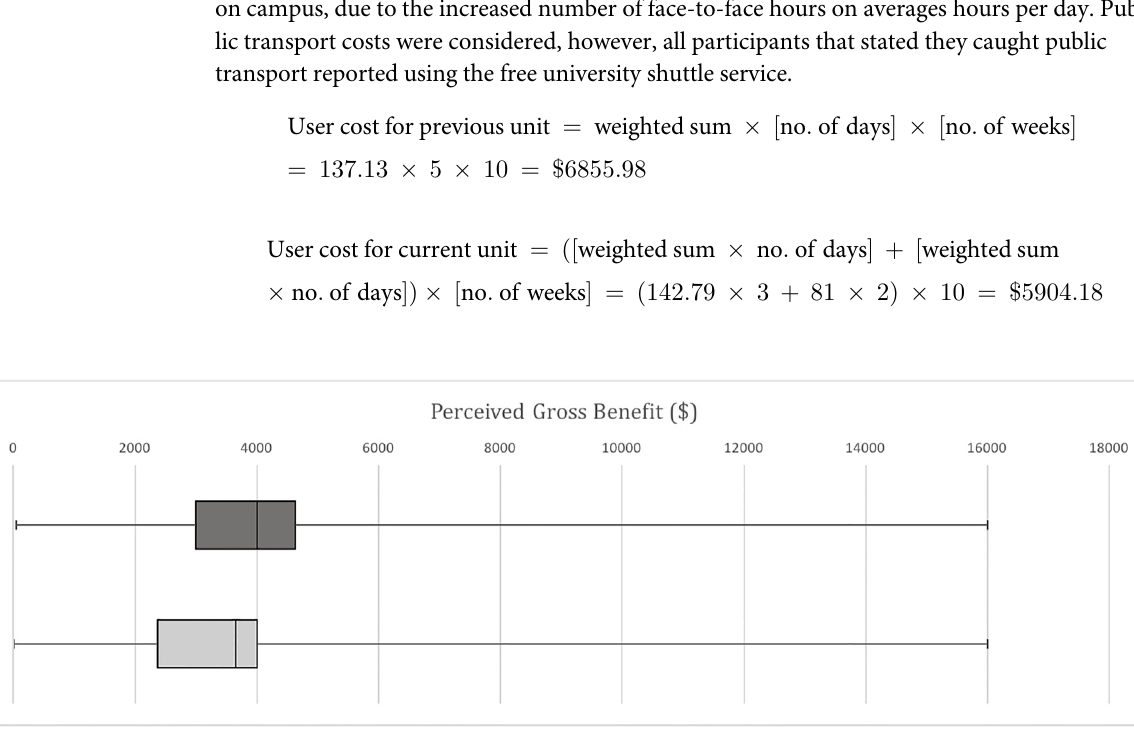
Fig 3. Comparison of Perceived Gross Benefit. Key: 1 = Current Unit Format; 2 = Previous Unit Format. 5-number summary (min, 1st quartile, median, 3rd quartile, max): Current Unit Format = 50, 3000, 4000, 4625, 16000; Previous Unit Format = 10, 2375, 3650, 4000,